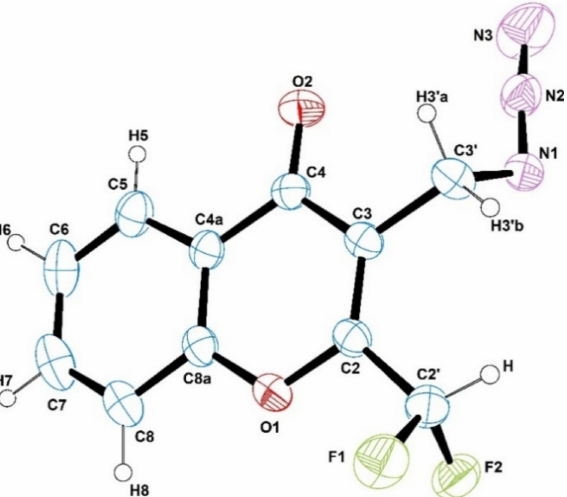
Figure 1. ORTEP plot of chromone 4 showing the labeling of the non-H atoms and their displacement ellipsoids at the 30% probability